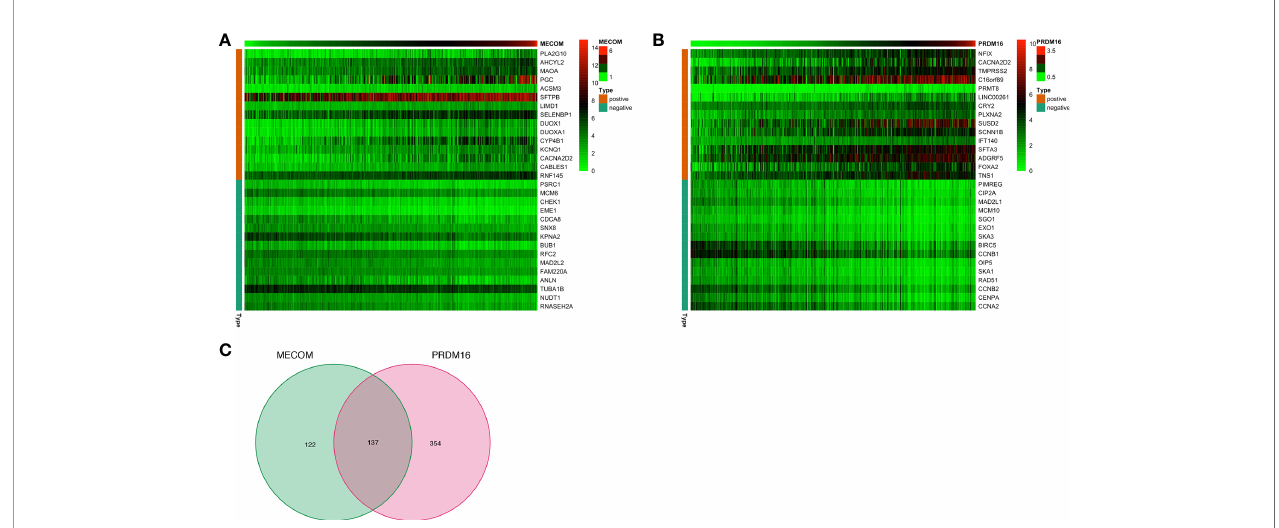
FIGURE 8 | The top 15 coexpression genes of MECOM (A) and PRDM16 (B) in LUAD in the cBioPortal database. (C) Intersection coexpression genes of MECOM and PRDM16. Note: Genes with |r| > 0.4 and p < 0.001 were considered coexpression genes. MECOM, MDS1 and EVI1 complex locus, also called PRDM3; PRDM16, PR domain containing 16, also called MEL1; LUAD, lung adenocarcinoma.